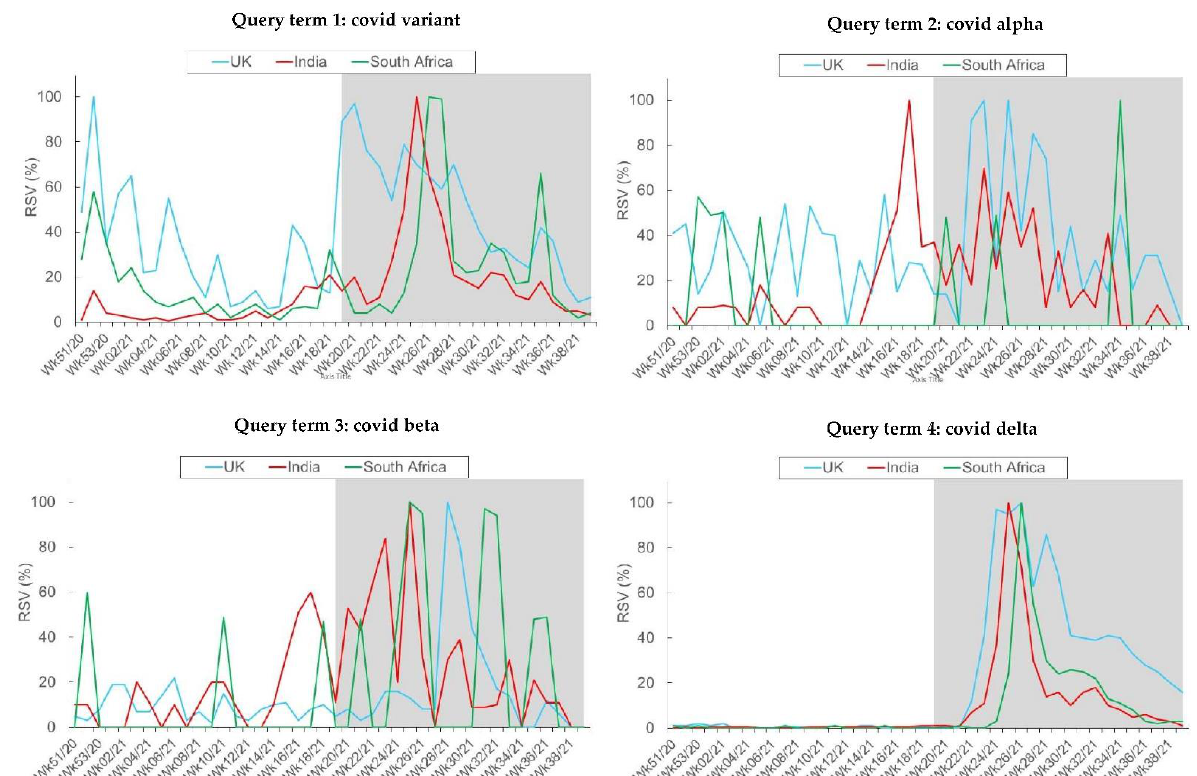
Figure 4. Weekly variations in relative search volumes (RSVs) of query terms related to COVID-19 variants by country. The study period spanned from Epi Week 51 2020 (13 – 19 December 2020) to Epi Week 38 2021 (19 – 25 September 2021). The gray area depicts the Delta-predominant period. Data adapted from the Google Trends TM website.